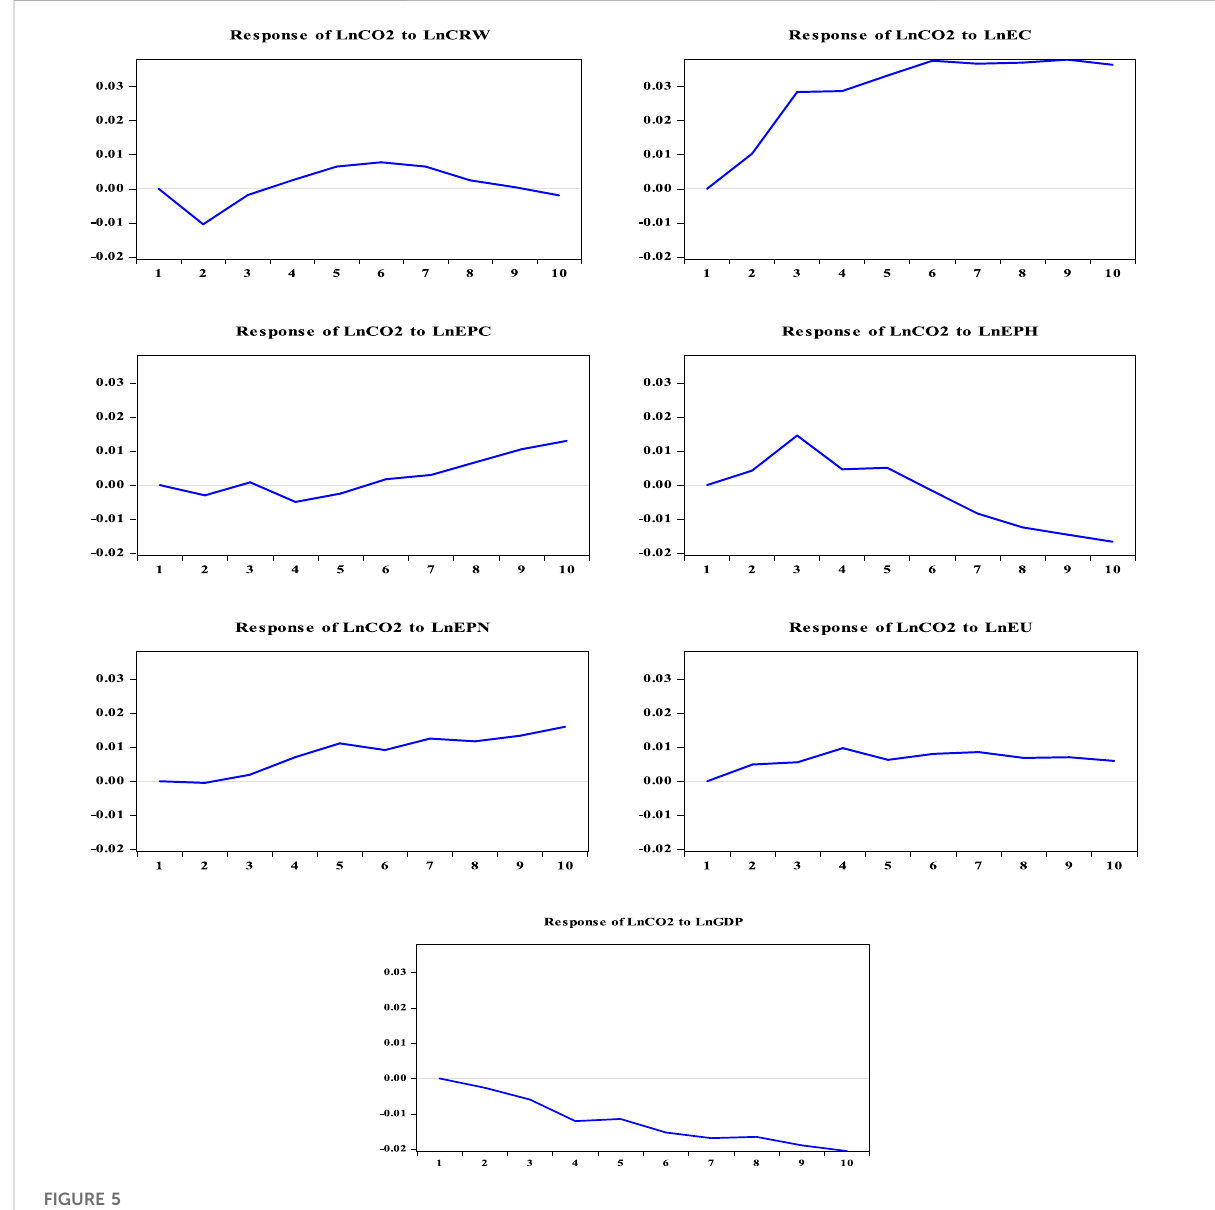
FIGURE 5 Impulse response of CO 2 emissions to other